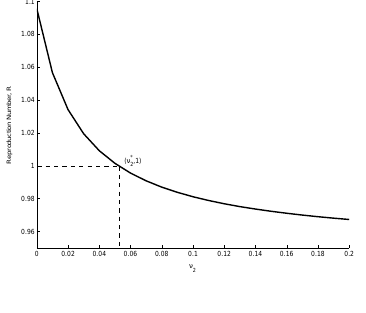
Figure 3. Profile of populations for the following parameter values µ = 0 . 03 , p 1 = 0 . 7 , ν 1 = 0 . 6 , ǫ = 0 . 3 , b = 0 . 03 , σ = 0 . 6 , π = 10000 , d = 0 . 4 , β 1 = 0 . 4 , β 2 = 0 . 08 , β 3 = 0 . 3 , µ 0 = 0 . 03 , τ = 13 years, c = 2 , ρ = 0 and q = 0 . 01